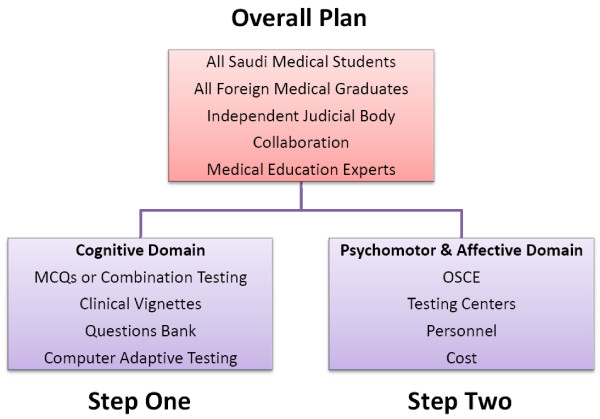
Summary of Proposal.